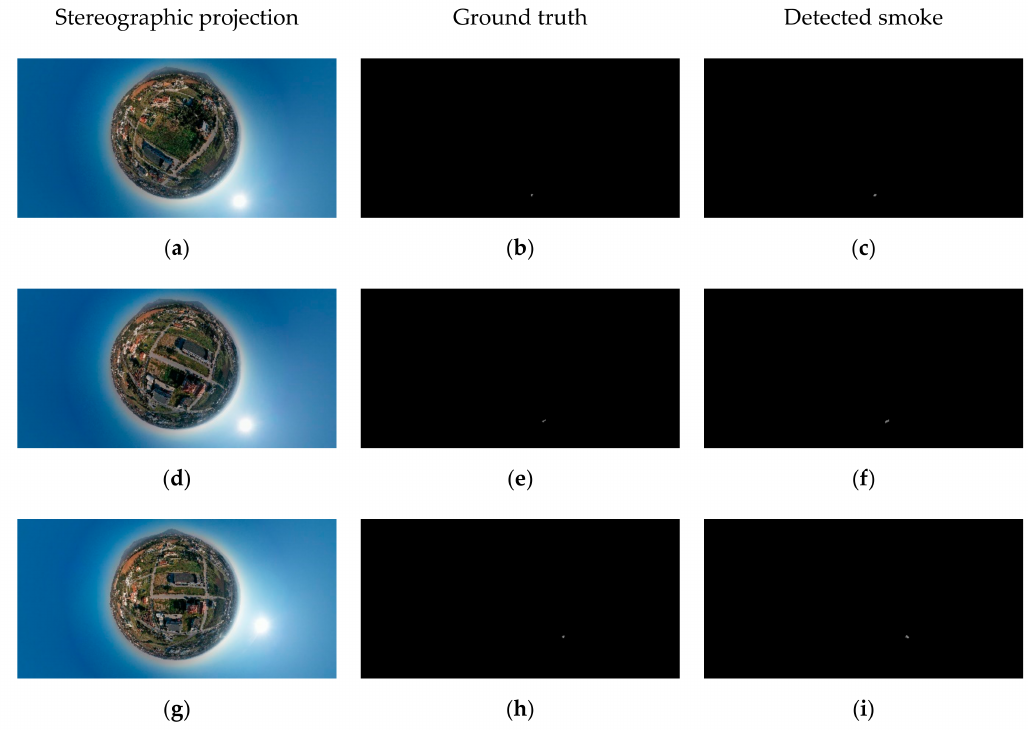
Figure 8. Results of the proposed methodology in 360-degree images containing real fire events of the “Fire detection 360-degree dataset”. Equirectangular “360-FIRE” images containing flame ( a – c ), containing smoke ( d – f ) and containing both flame and smoke ( g – i